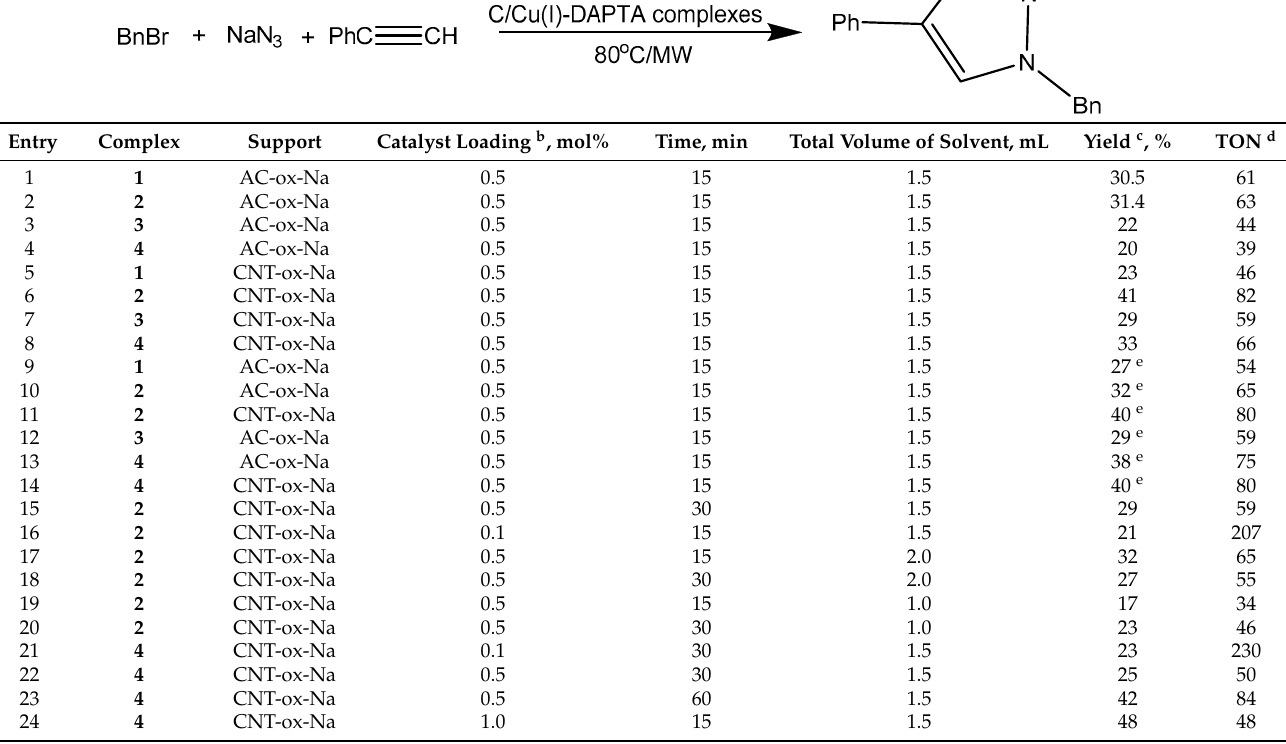
Table 3. The 1,3-dipolar azide-alkyne cycloaddition catalyzed by Cu(I)-DAPTA complexes ( 1–4 ) anchored on different carbon supports a .